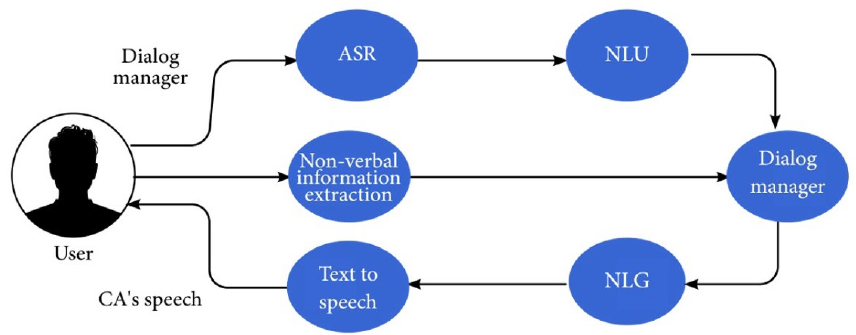
Figure 5. The main voice-based components of